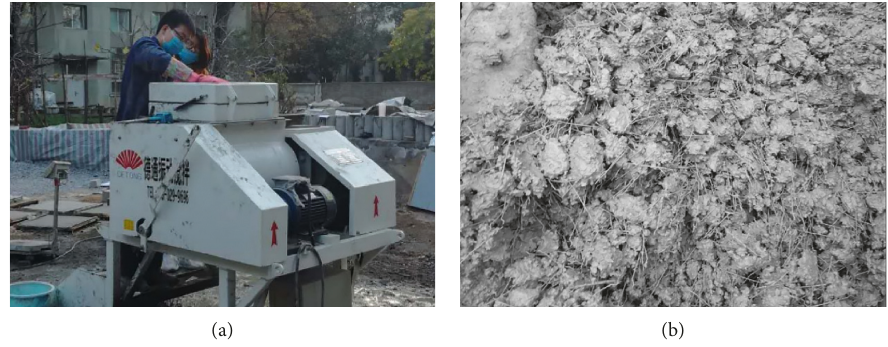
Figure 1: Mixing process of steel fiber concrete by vibratory